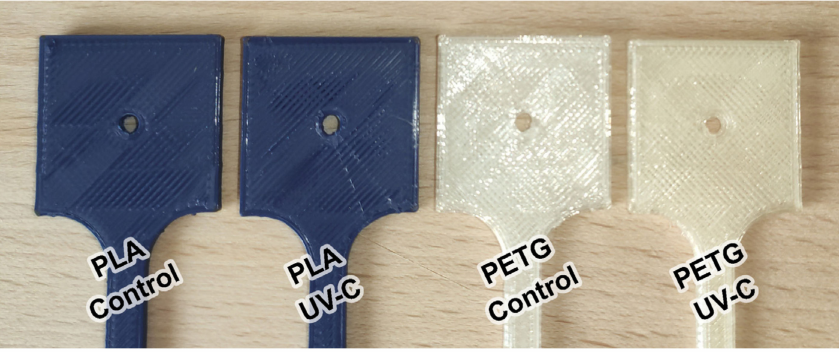
Figure 3. Changes in material color and reflectivity following UV-C